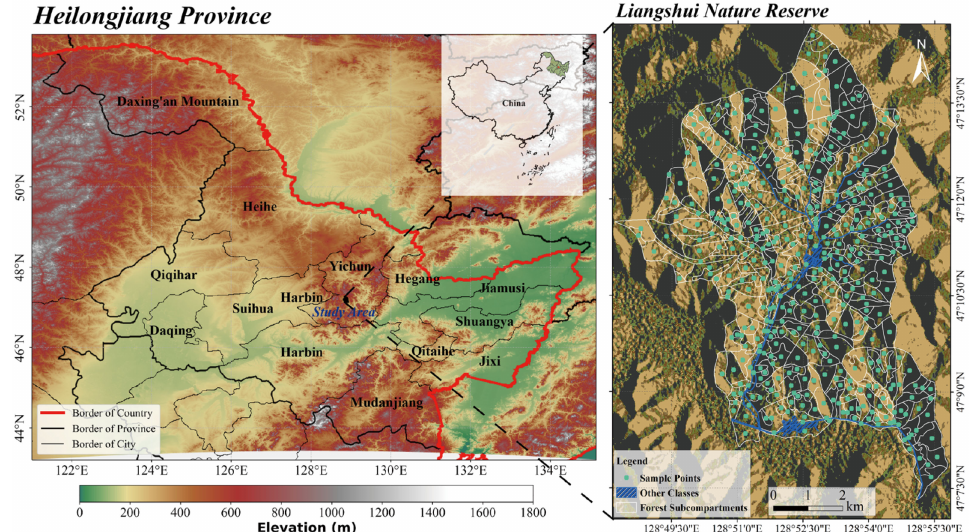
Figure 1. Geographical location of the study area and forests subcompartments distribution in the Liangshui Nature